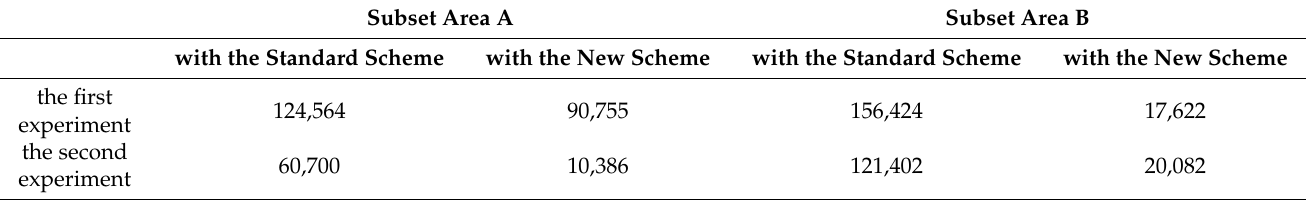
Figure 9. Percentage of false positive pixels in each 1 × 1 km cell that falls into intervals defined by breaks 0.1%, 1%, 5%, 10%, 20%, 30%, and 40%. The percentage of false positive pixels of different settings of classification scheme and feature selection for mangrove-rich area in Hainan are shown in the left panel as ( a , d , g , j ), the one for mangrove-rich area at the estuary in Guangdong in the middle panel as ( b , e , h , k ), and the one for non-mangrove area at the estuary in Zhejiang in the right panel as ( c , f , i , l ). Table 6. Number of false positive pixels in the two selected subset areas in two